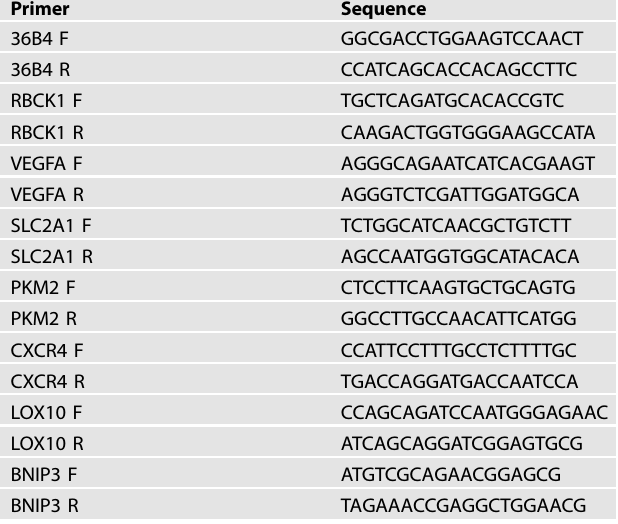
Table 1. The primer sequence of qPCR